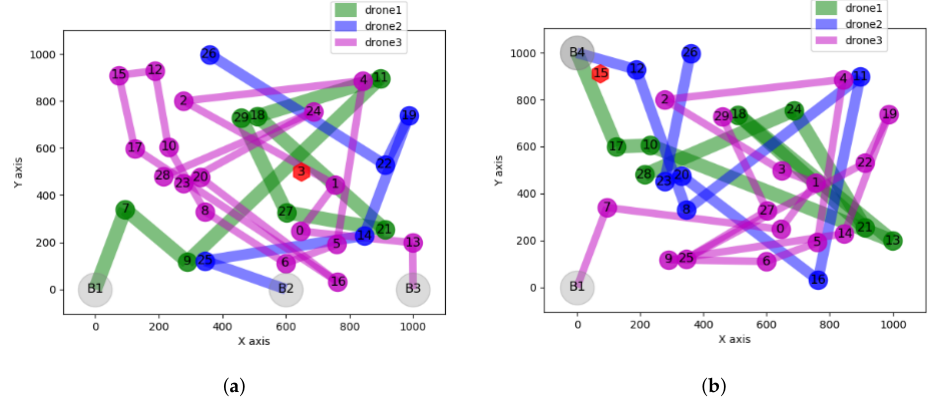
Figure 16. First two visitations. ( a ) First visitation; ( b ) Second